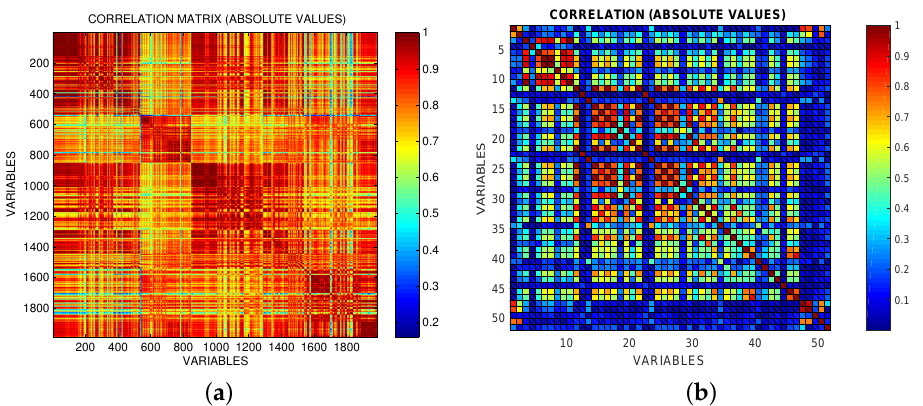
Figure 2. Absolute value of the correlation matrix for the semiconductor dataset (OES data) ( a ) and Fabric Care Appliance dataset: ( b